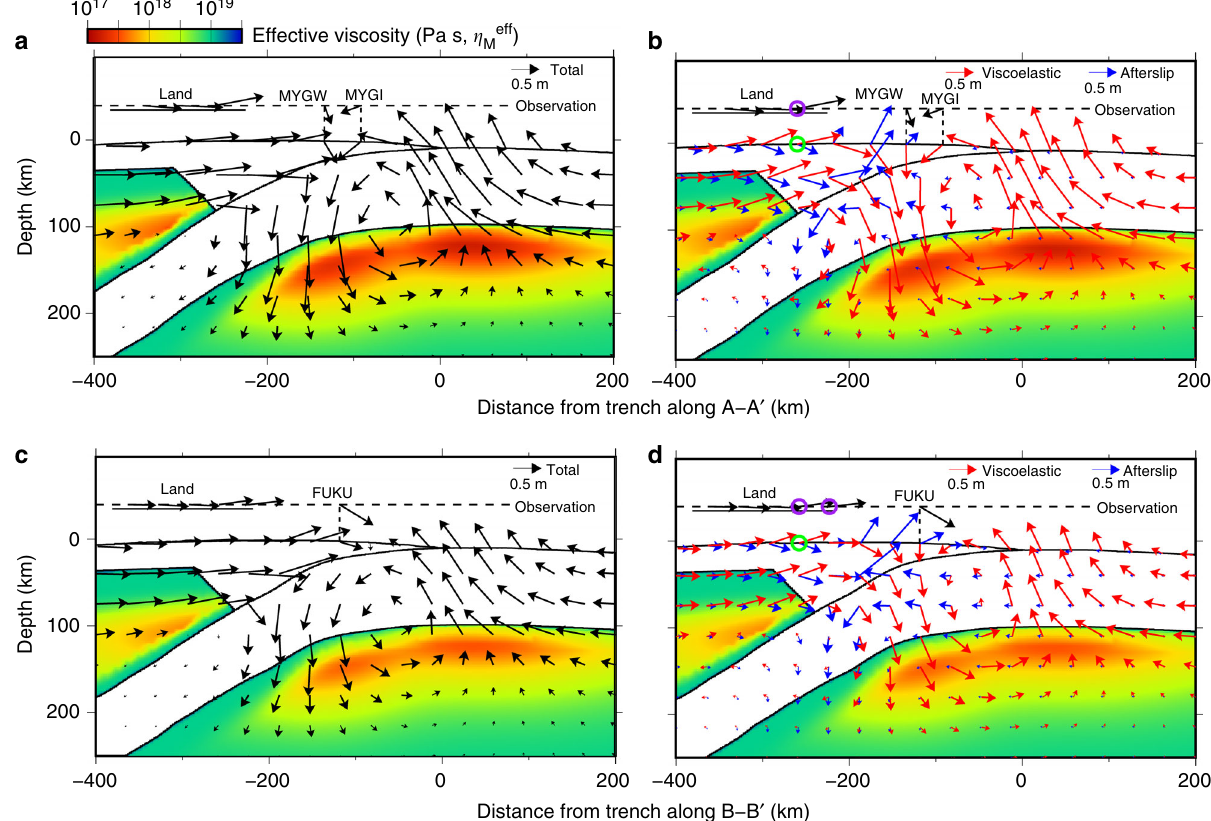
Fig. 7 Simulation results on the vertical cross-sections parallel to the plate convergence direction, going through sea fl oor stations. a Displacement in the A – A ′ pro fi le with MYGW and MYGI and b decomposition into contribution from viscoelastic relaxation and afterslip. c Displacement in the B – B ′ pro fi le, which is parallel to A – A ′ and runs by the station FUKU and d decomposition into contribution from viscoelastic relaxation and afterslip. The fi gures on the left are for the total displacement after 2.8 years. The panels on the right show the contribution from elastic deformation due to afterslip and viscoelastic fl ow after 2.8 years. The color indicates the distribution of effective viscosity in the Maxwell element shortly after the earthquake. The black arrows on the horizontal dashed line are the observed displacements. In the location of purple circles, observation data shows uplift, while in the green circles, computed uplift viscoelastic displacement is canceled out by subsidence due to